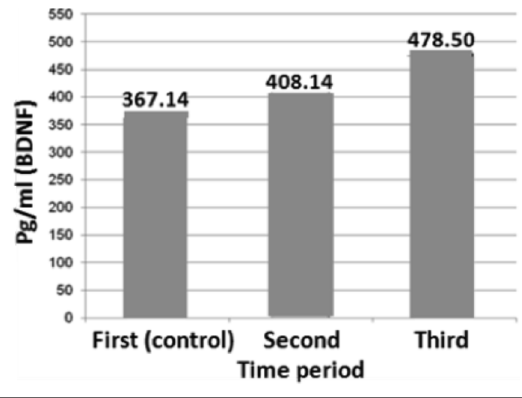
Figure 2. Effect of fasting on nerve growth factor levels on 14 th (second) and 29 th (third) day of Ramadan compared to the con- trol group. All data are expressed as mean±standard error of mean;